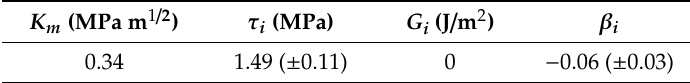
Figure 7. Single fiber pullout load and pullout distance curves of specimens (Different colors of lines indicate different samples with identical mixture.). Table 5. Matrix fracture toughness and interfacial